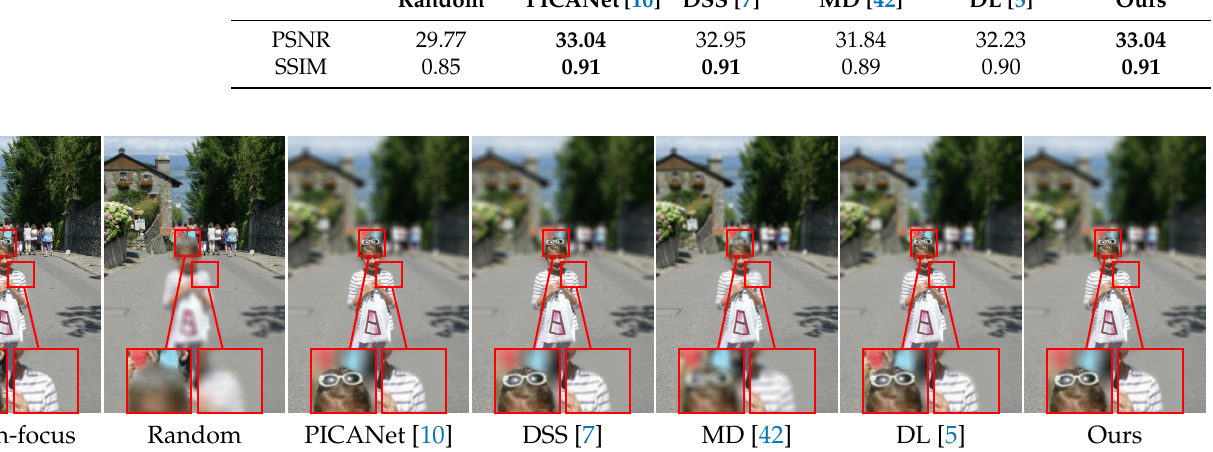
Figure 15. Impact of the SOD module and the MDP module. Best viewed zoomed in